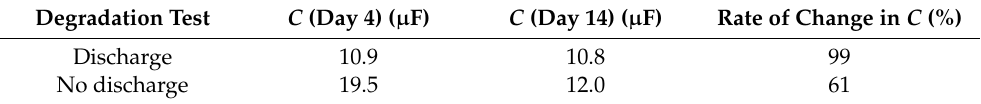
Table 3. Percentage change in C in the degradation tests with and without discharge. Degradation Test